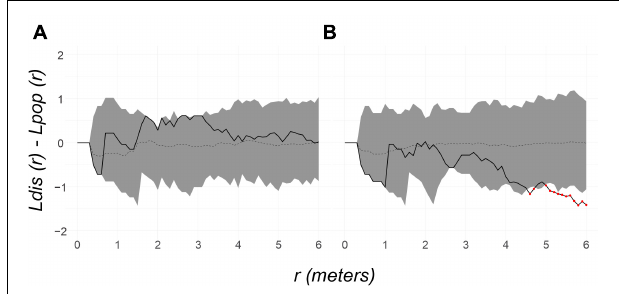
FIGURE 7 | Random labeling test for the newly diseased colonies in the two Bocana analyzed periods: (A) Aug to Sep of 2018. The spatial pattern of the survey sample is random (solid line is within the 95% shaded confidence envelope and p = 0.45) and (B) Oct of 2018 to Apr of 2019. The spatial pattern is overdispersed at 4.5–6 m distance scale [pattern is under the envelope (red dots marking it) and p =